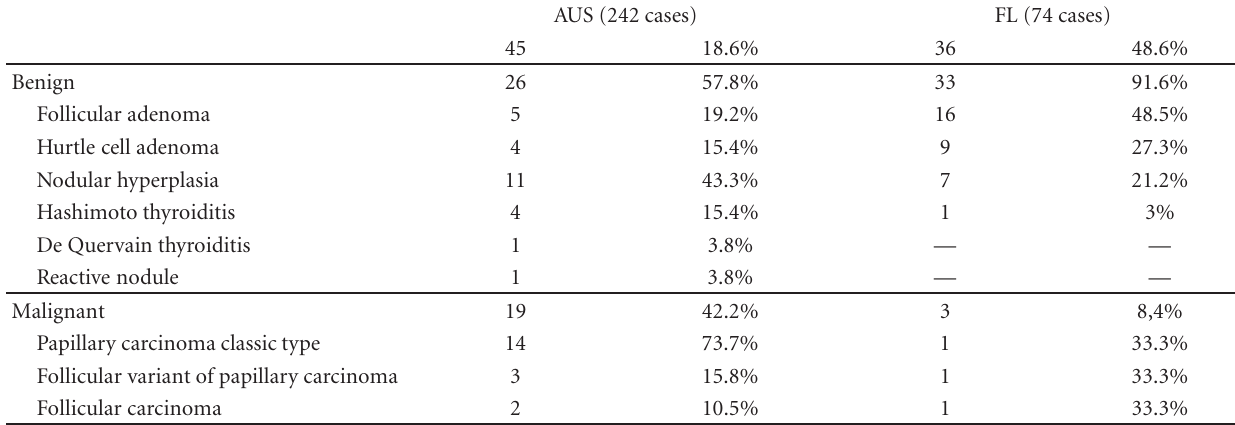
Table 1: Histologic followup of cases.